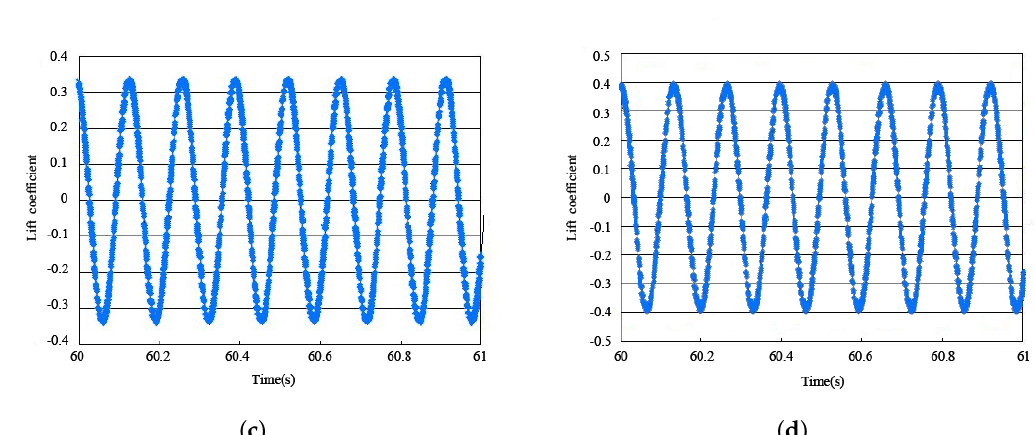
Figure 5. Variation curves of the lift coefficient of the TTR with time at different underwater depths: ( a ) lift coefficient curve at 1 m underwater; ( b ) lift coefficient curve at 2 m underwater; ( c ) lift coefficient curve at 3 m underwater; ( d ) lift coefficient curve of the entire riser.